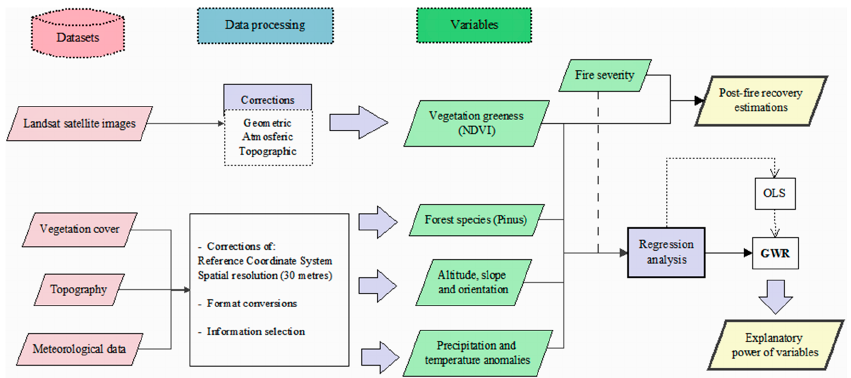
Figure 2. Overall methods implemented in our study. OLS: Ordinary Least Square. GWR: Geographically Weighted